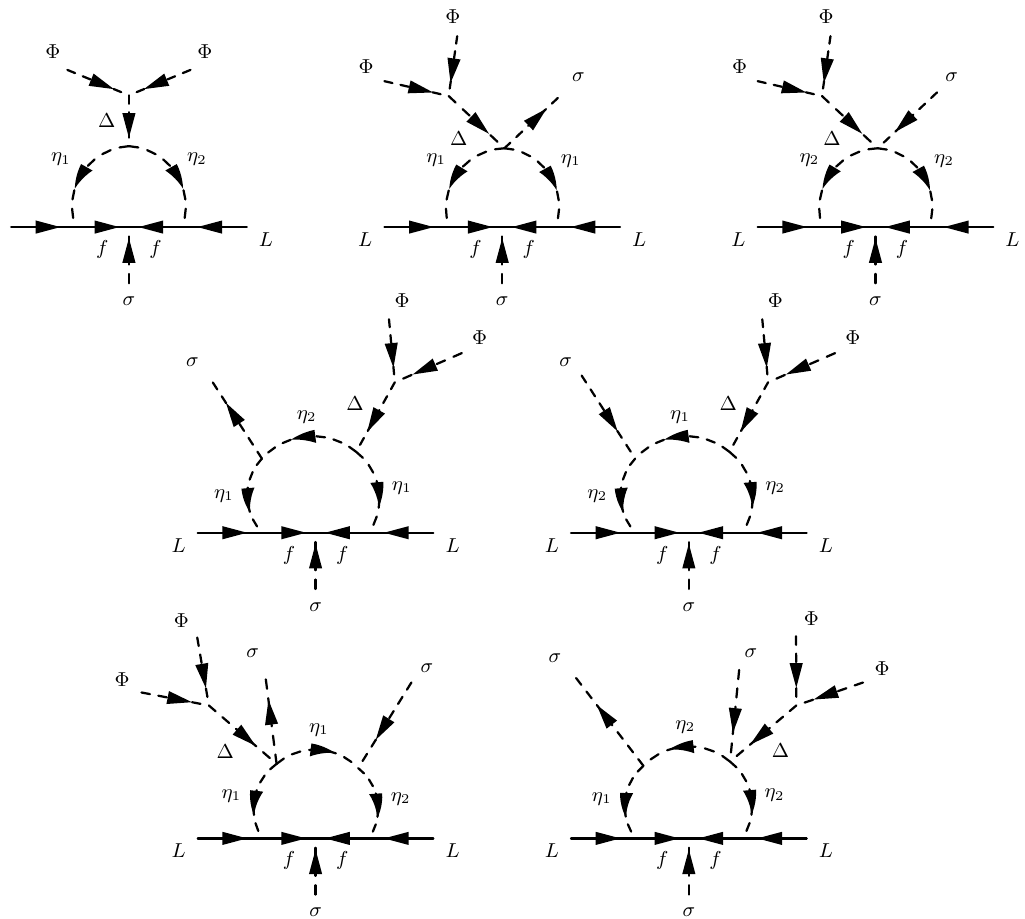
Figure 2 . One-loop contributions to the dimension-6 operator LL ΦΦ σ (first row diagrams), to the dimension-7 operators LL ΦΦ σσ ∗ and LL ΦΦ σσ (second row diagrams), and to the dimension-8 operator LL ΦΦ σσσ ∗ (third row diagrams), involving the triplet ∆